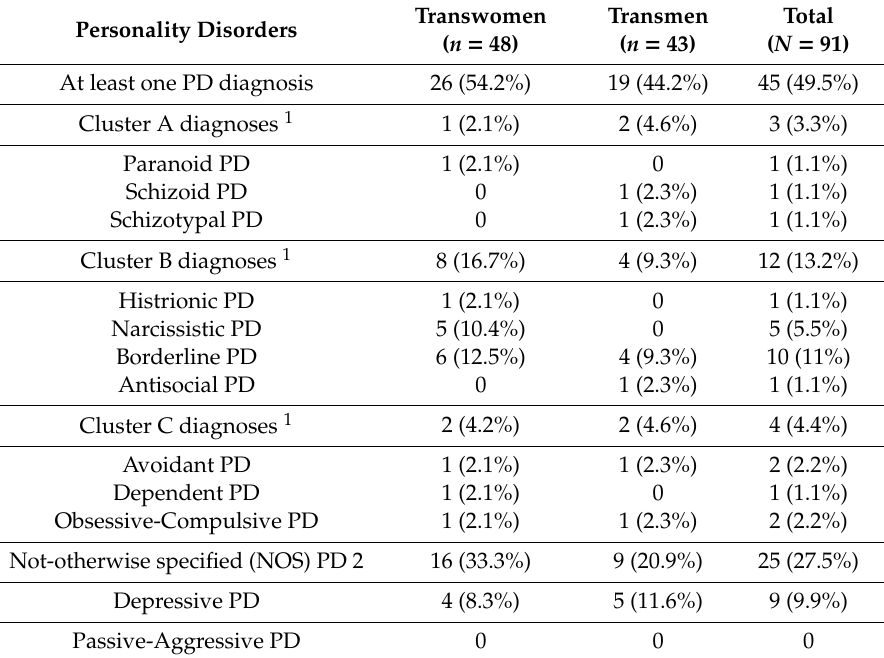
Table 3. Prevalence of personality disorders in the two